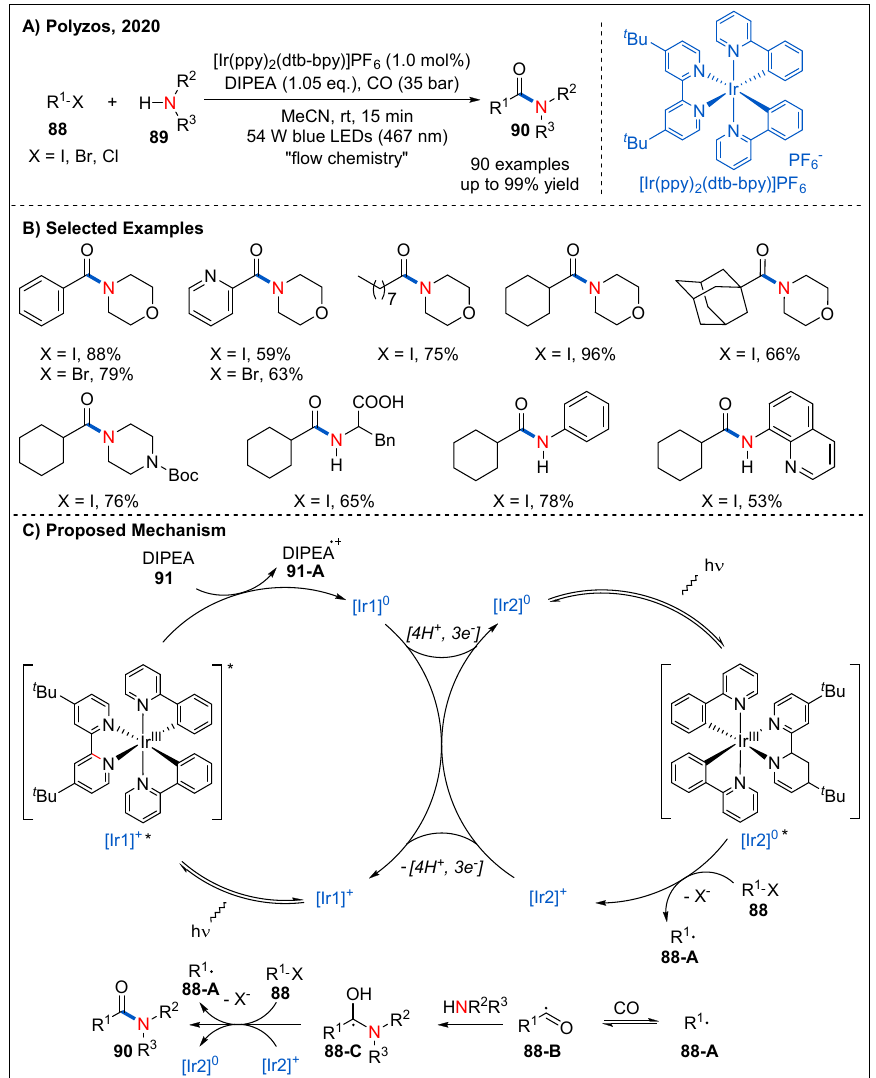
Figure 28. Photoinduced aminocarbonylation of aryl and alkyl halides by tandem photoredox catalysis.